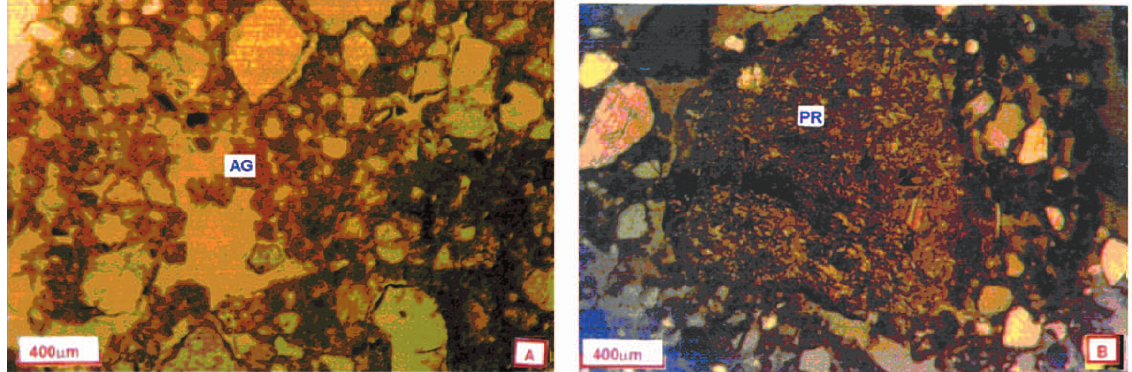
Figura 7. Fotomicrografias. A – agregados (AG) microestrutura granular do horizonte Bt do perfil 2, em PPL; B – pedorrelíquia (PR) no horizonte Bt do perfil 2, em